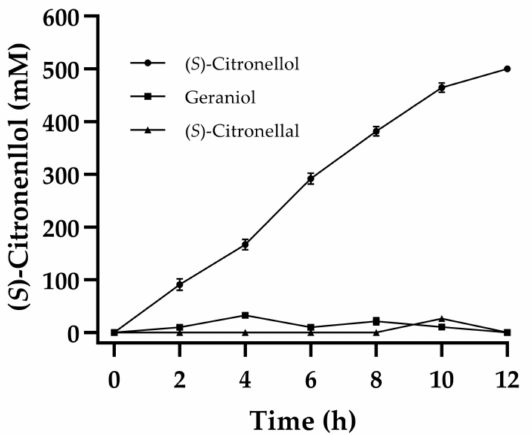
Figure 7. The synthesis of ( S )-citronellol in the manner of substrate constant feeding. The initial reaction mixture (10 mL) contains 100 g/L wet cells co-expressing three enzymes, 0.4 mM NADP + , 4% ( v / v ) isopropanol and 50 mM PIPES buffer (pH 6.5). The loading of 500 mM substrate and 1500 mM glucose was constantly fed within 10 h. The reaction was performed at 30 ◦ C and 400 rpm for 12 h. Constant pH was kept through the titration of 1 M NaOH. Standard deviations are indicated in the diagram ( n =